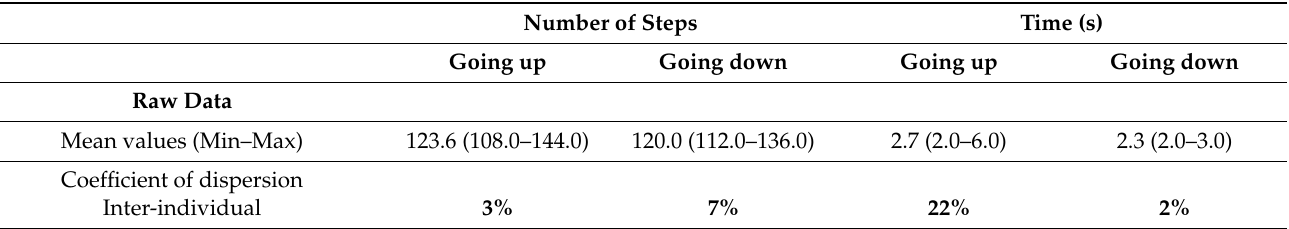
Table 6. The Finish Line Completed descriptive analysis.